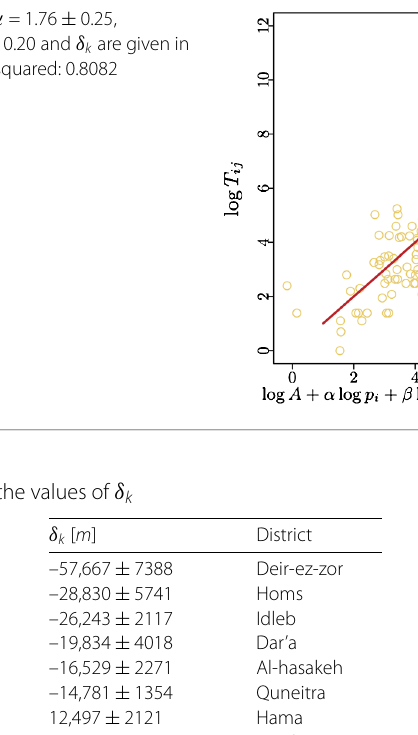
Table 1 and the Multiple R -squared: